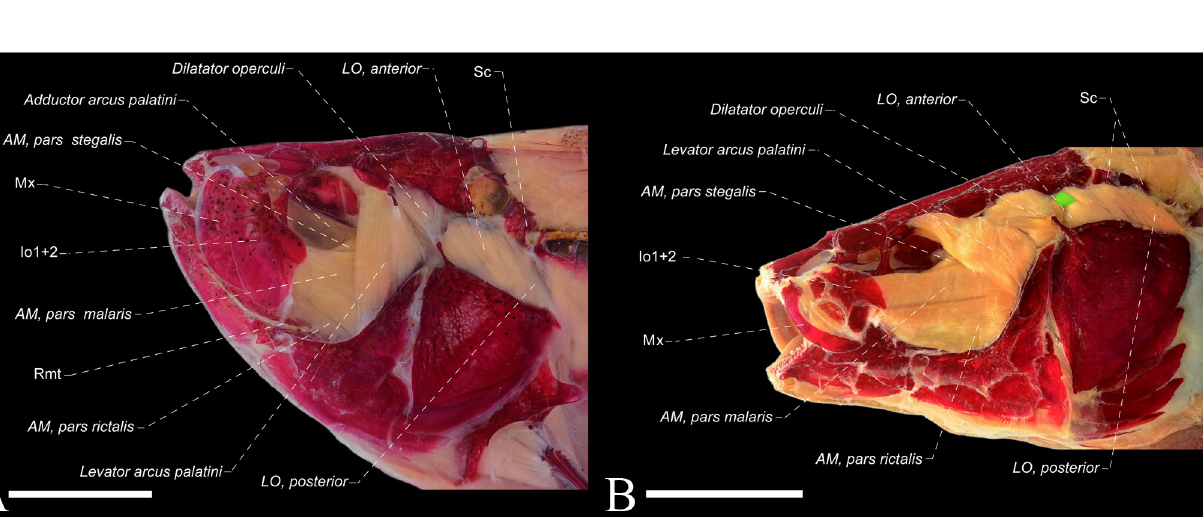
PLOS ONE | https://doi.org/10.1371/journal.pone.0220287 August 14,